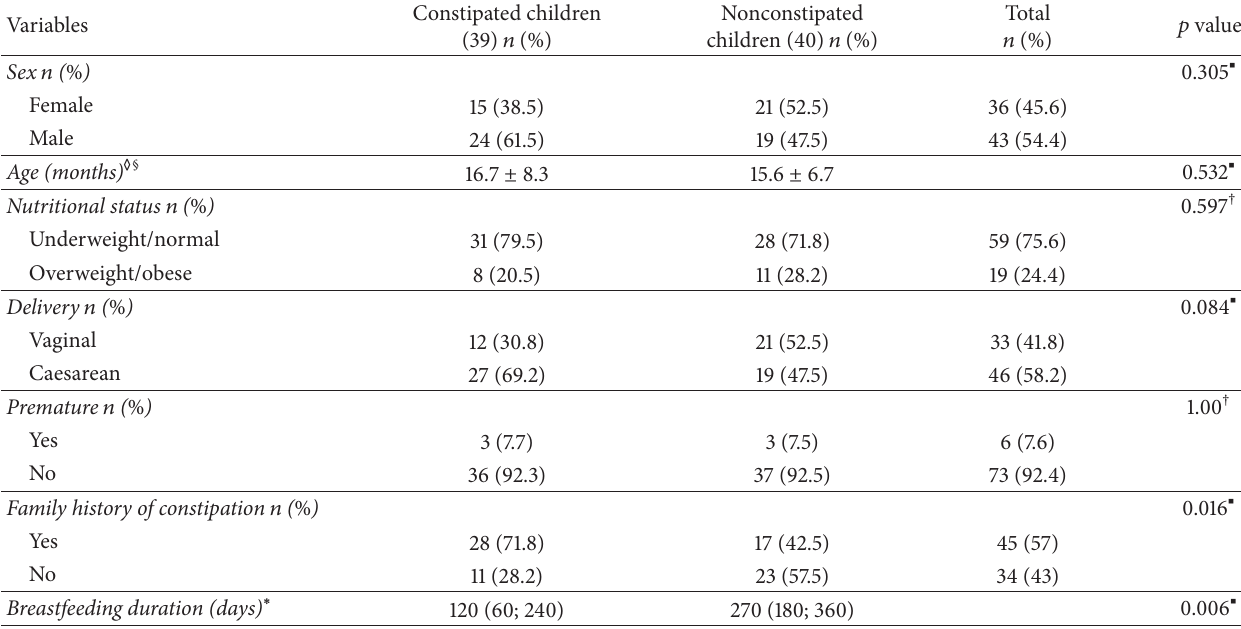
Table 2: General characteristics of the sample.